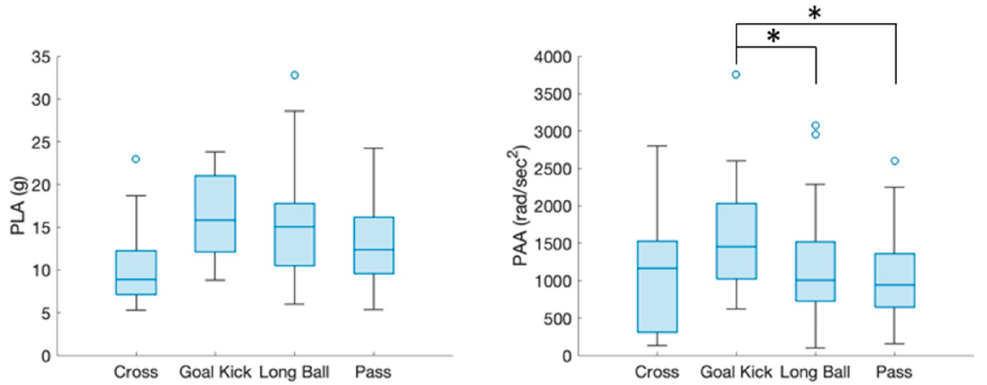
Figure 3. Heading kinematics based on the ball delivery methods cross (n = 13), goal kick (n = 18), long ball (n = 42) and pass (n = 60). Asterisks (*) indicate statistical significance between goal kicks and both long balls ( p = 0.024) and pass attempts ( p = 0.011). Tabulated results are available in Ap-